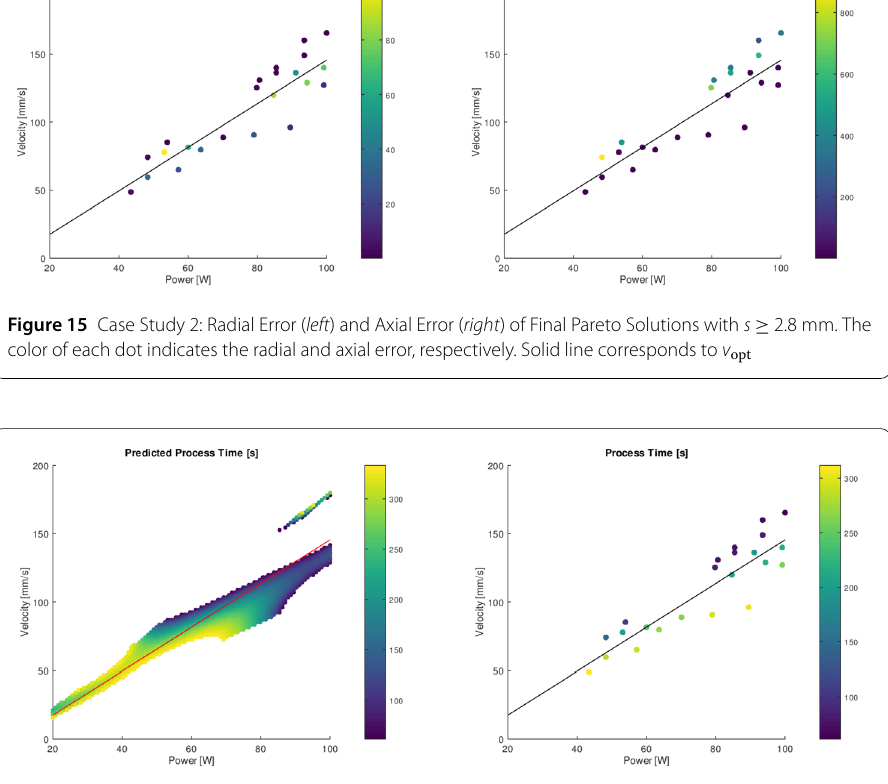
Figure 16 Case Study 2. Left : Predicted Process time [s] at s = 3.0 mm using last metamodel (iteration k = 3). Right : Process Time of Final Pareto Solutions with s ≥ = 2.8 mm. In both cases, the process time is shown as indicated by the the color bars and the solid line corresponds to v